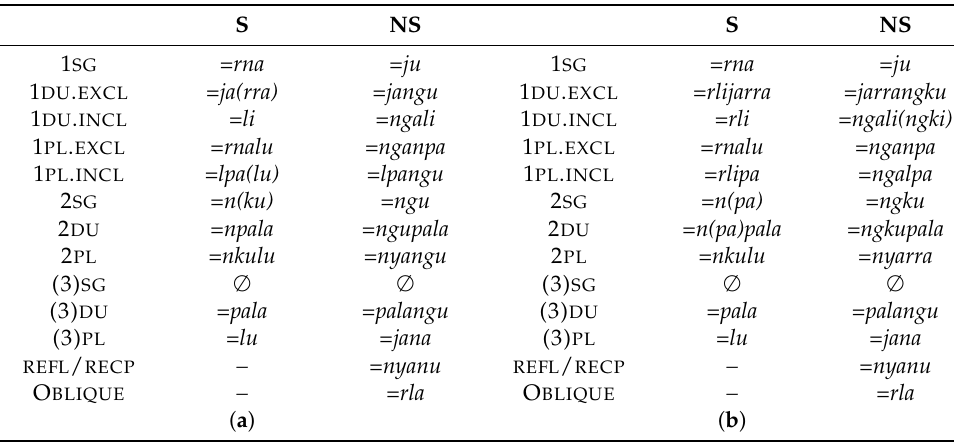
Table 1. Forms of bound pronouns in Warlmanpa ( a ) and Warlpiri ( b